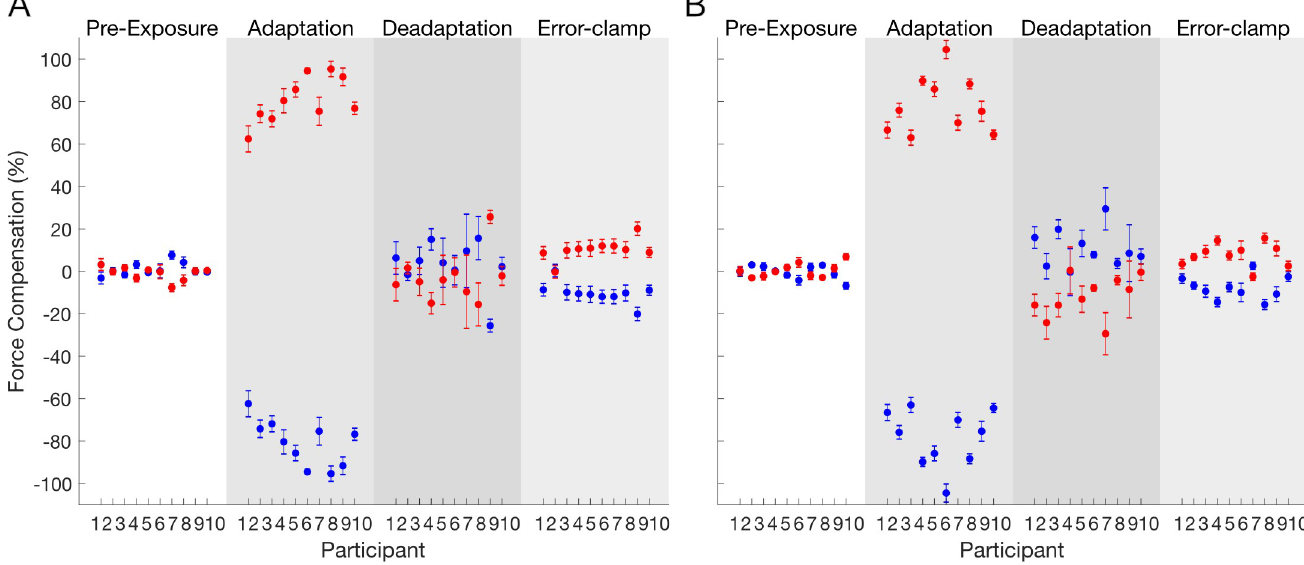
Fig 8. Distribution of individual participants in force compensation for experiment 1 (A) and experiment 2 (B). Each point represents the mean and standard error of force compensation over pre-exposure (white), adaptation (grey), de-adaptation (dark grey) and error-clamp (light grey) phases. For each subject, the force compensation for the two contextual cues is symmetrical due to the subtraction of the mean force compensation across cues.